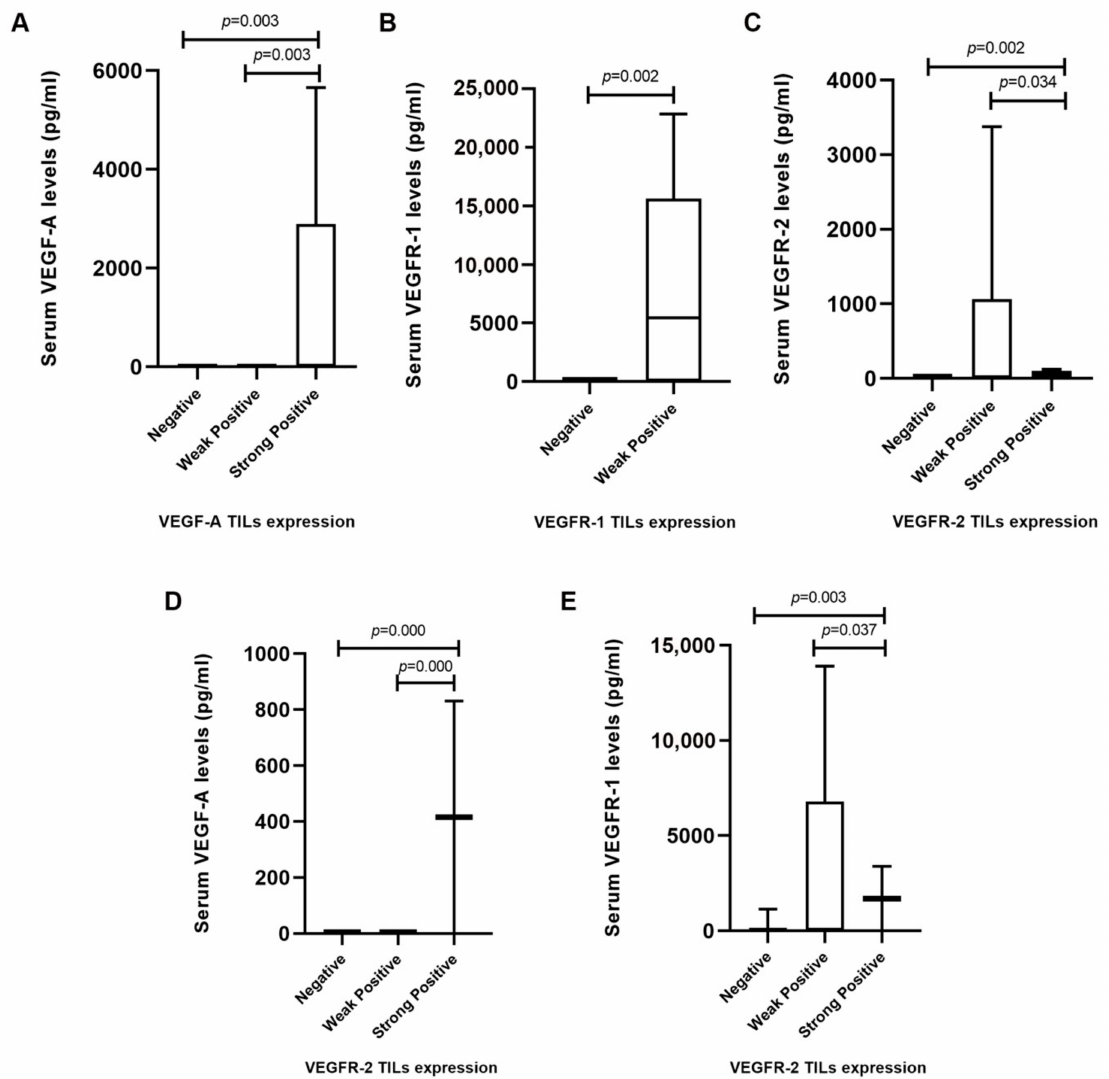
Figure 4. Serum levels and IHC scores of vascular endothelial growth factor (VEGF-A), vascular endothelial growth factor receptor 1 (VEGFR-1) and receptor 2 (VEGFR-2) in tumor infiltrating lymphocytes (TILs) of cats with mammary carcinoma. ( A ) Cats with tumors and a positive score for TILs showed higher serum VEGF-A, ( B ) VEGFR-1 and ( C ) VEGFR-2 levels in comparison with cats that showed a negative score for TILs. ( D ) Box plot diagrams showing that queens with mammary carcinomas scored as VEGFR-2-positive TILs had high serum VEGF-A and ( E ) VEGFR-1